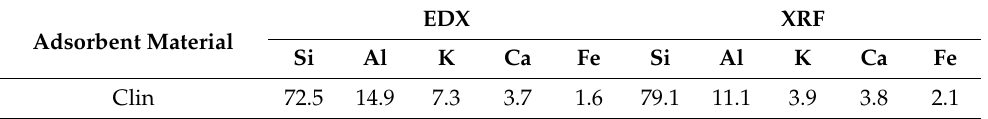
Table 2. EDX and XRF results are reported as atomic